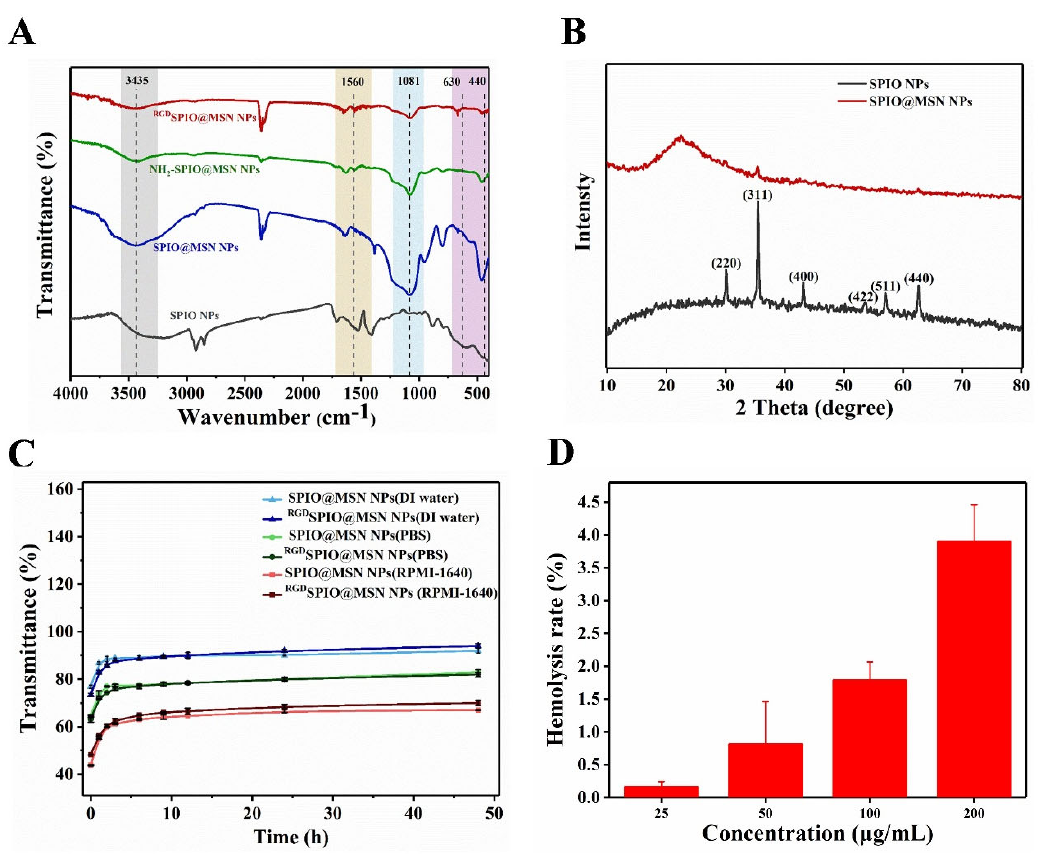
Figure 2. ( A ) FT ‐ IR spectra of SPIO NPs, MSN NPs, SPIO@MSN NPs and RGD SPIO@MSN NPs. ( B